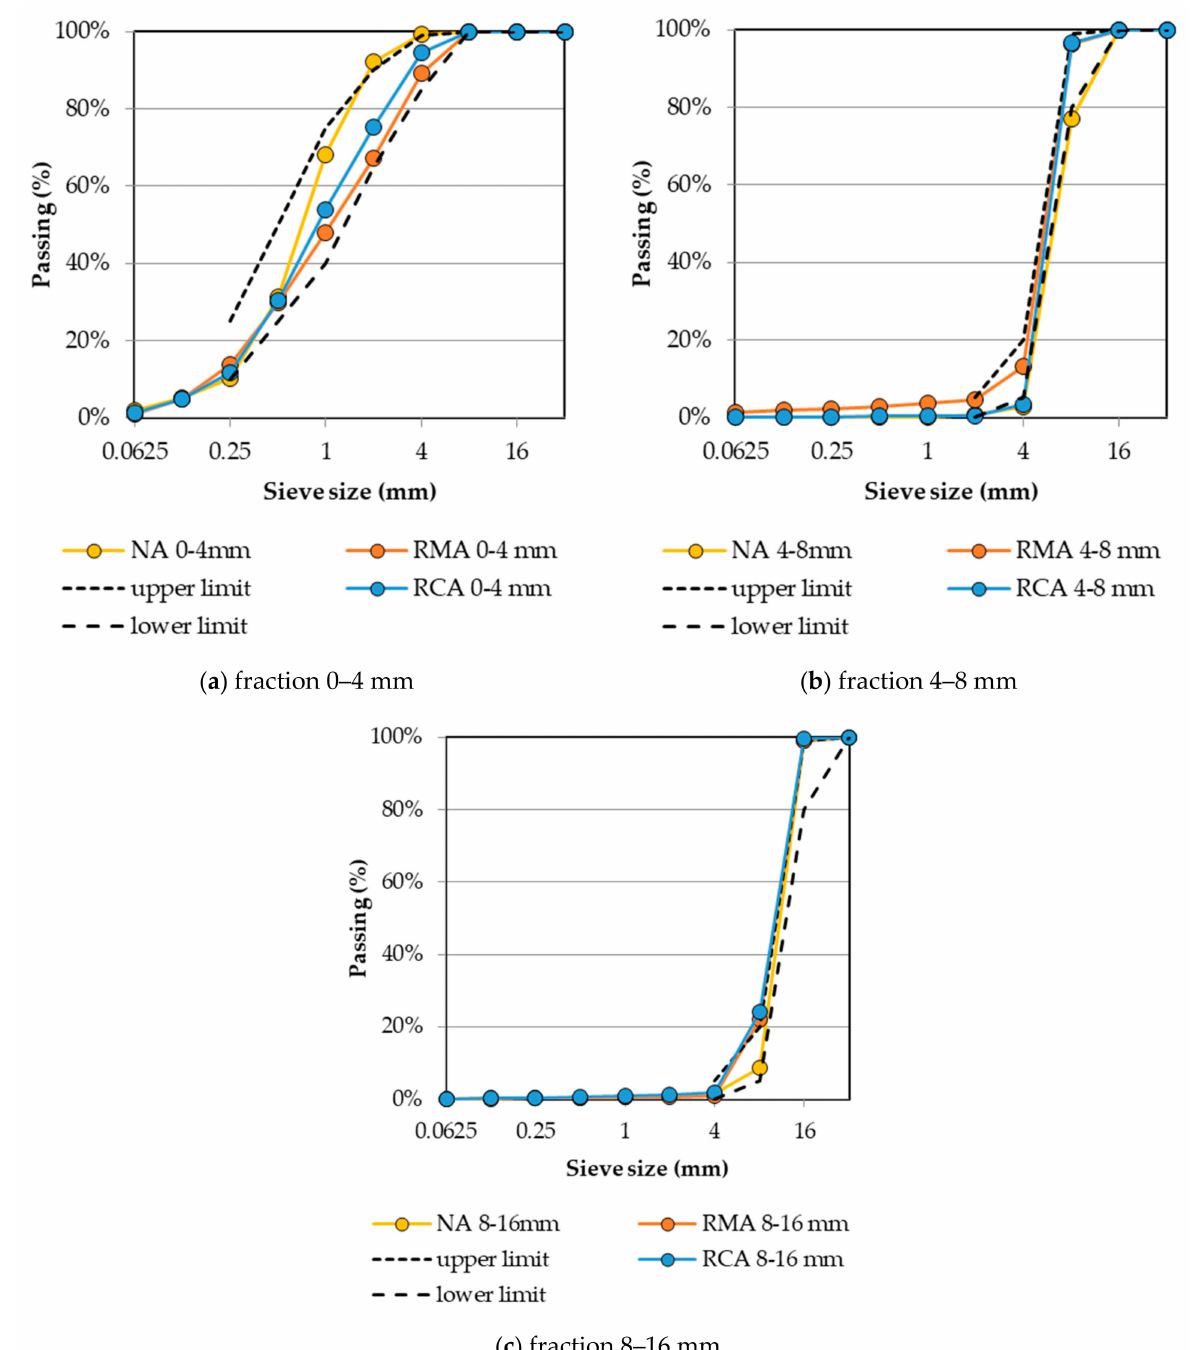
Figure 3. Sieving curves for natural aggregate, recycled masonry aggregate with limits defined in the standard [77] used in concrete